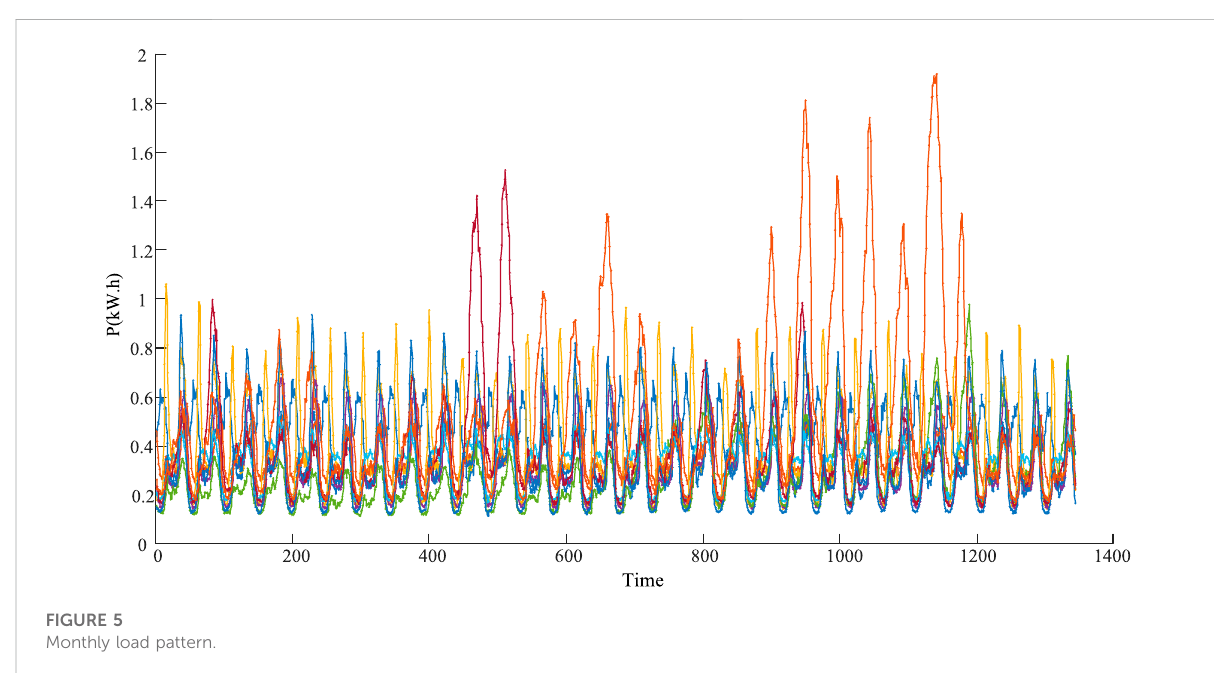
FIGURE 5 Monthly load pattern.